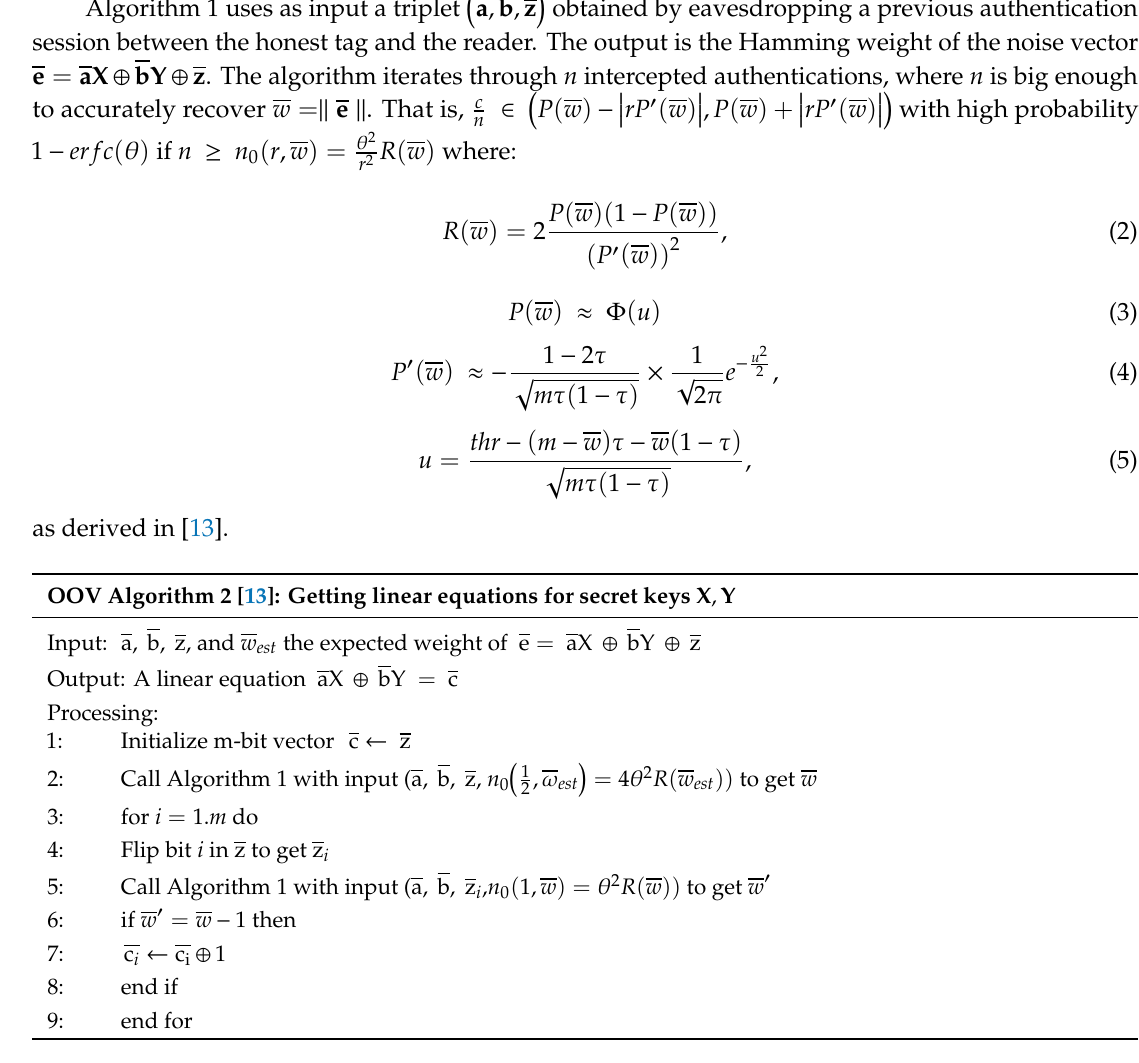
Algorithm 2 takes as input ( a , b , z ), a triplet obtained by eavesdropping a communication session between the honest tag and the reader, and the expected weight w est of e = aX ⊕ bY ⊕ z , and it recovers a linear combination of the secret keys aX ⊕ bY = c